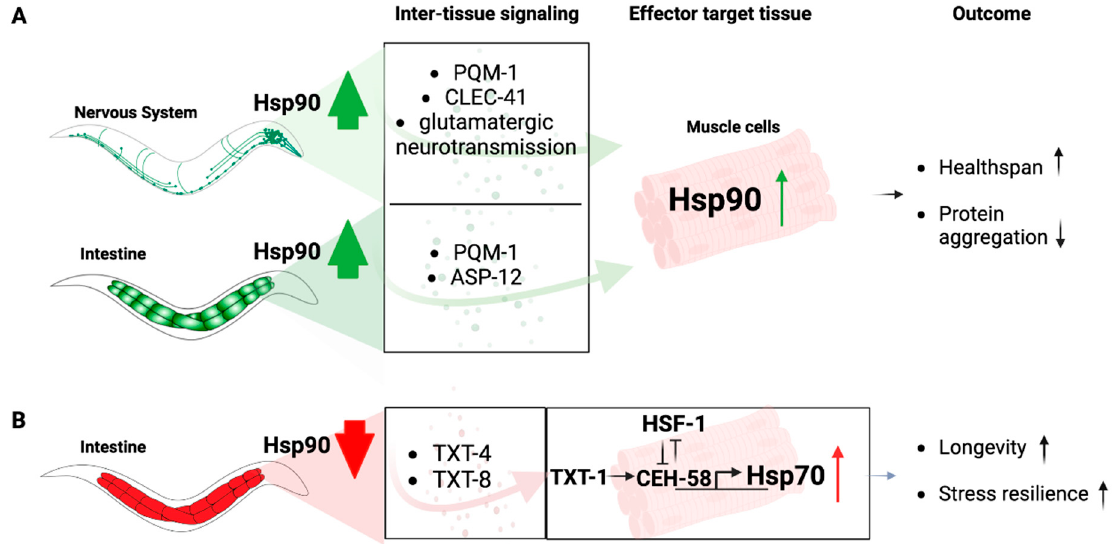
Figure 2. Transcellular chaperone signaling pathways. ( A ) Overexpression of Hsp90 in the nervous system mediates upregulation of Hsp90 in muscle cells via PQM-1, CLEC-41 and glutamatergic neurotransmission. Overexpression of Hsp90 in the intestine relays the signal to upregulate Hsp90 in muscle cells via PQM-1 and ASP-12. The transcription factor regulating Hsp90 in muscle cells in response to TCS has not been determined. The organismal consequences are increased health span and reduced protein aggregation in the muscle tissue. ( B ) Knockdown of Hsp90 in the intestine relays the signal to muscle cells via the secreted lipases TXT-4 and TXT-8. There, TXT-1 signals to the transcription factor CEH-58 to induce Hsp70 expression, resulting in increased longevity and stress resilience. HSF-1 functions as a suppressor of this process.